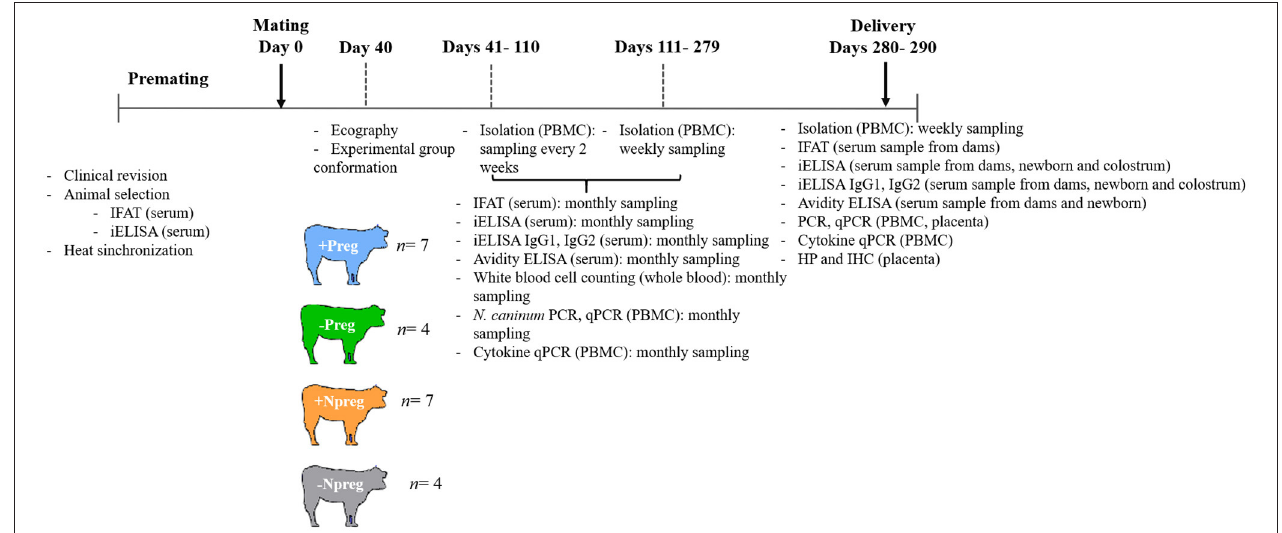
FIGURE 1 | Experimental design, sample schedule, and procedures carried